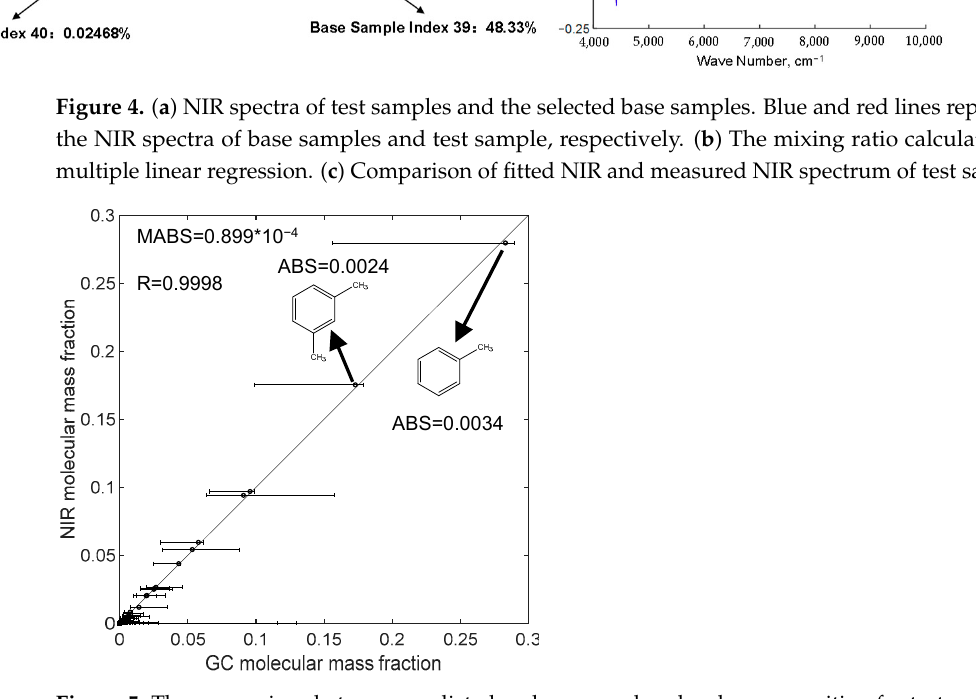
Figure 5. The comparison between predicted and measured molecular composition for test sample 2. The horizontal error bar at each point in the graph represents the fluctuating range of the composition of that molecule in the sample library.